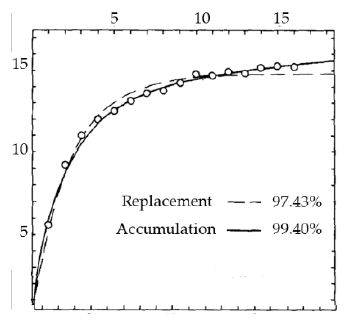
Figure 5. Two-parameter model graphic [20].